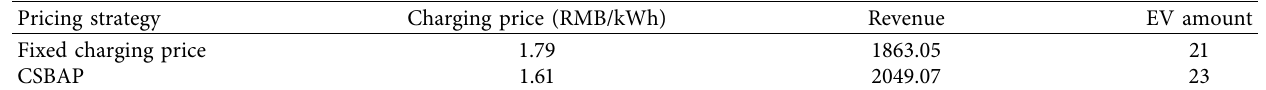
Table 9: Revenue of the charging station No. 6.